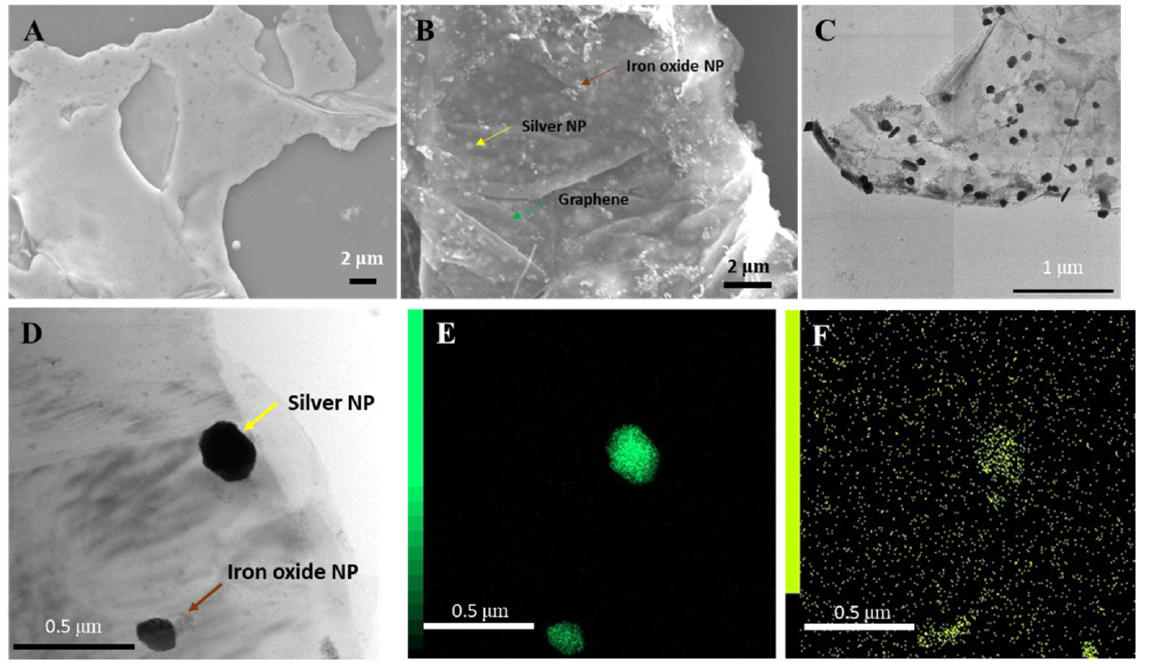
Figure 1. Structure observation of Ag/IO-GRP: SEM images of ( A ) bare GRP and ( B ) Ag/IONP-GRP, TEM image of ( C ) Ag/IO-GRP and EDS results, ( D ) bright field image, ( E ) Ag L mapping image, and ( F ) Fe K mapping image of Ag/MNP-GRP.